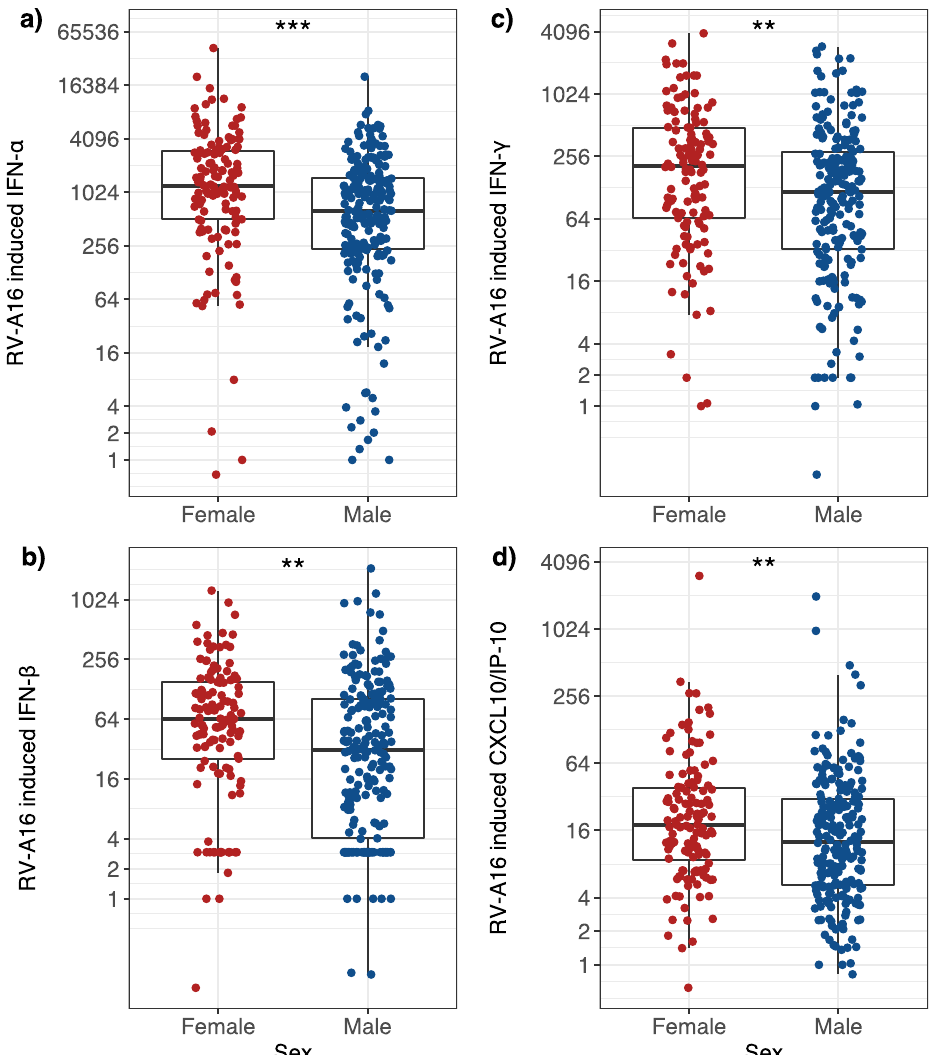
Figure 3. Females have significantly greater induction than males of type I and II IFNs and CXCL10/IP-10 in response to RV-A16. Box plots represent the 25th and 75th percentiles, the line the median, with whiskers at the 10th and 90th percentiles. Each dot represents an individual participant. Data were analysed using the Wilcoxon test. Adjusted P values: ( a ) P = 0.001, ( b ) P 0.003, ( c ) P = 0.017 and ( d ) P = 0.041. ‘***’ 0.001 ‘**’ 0.05 ‘*’ 0.1. Data are presented as fold induction. The y axis is plotted on a logarithmic